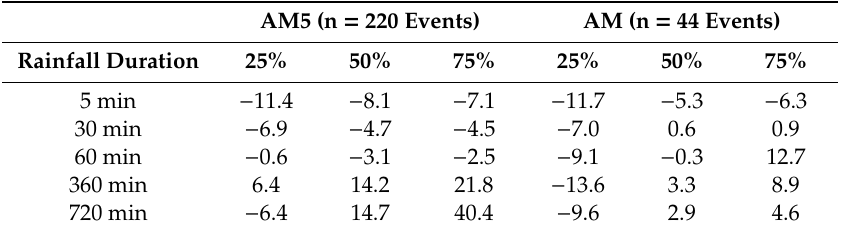
Table 4. Slope of the linear trend lines fitted to the 25%, 50%, and 75% data samples multiplied with the number of years in the sample. Thus, results indicate the change in the number of Julian days for the entire 44 years.